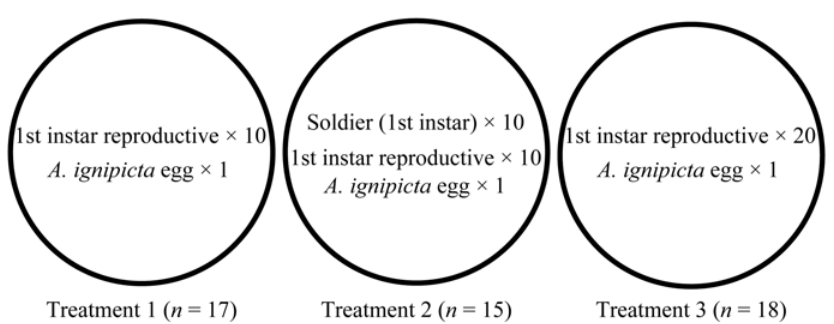
Fig. 2. The design of the egg hatching experiment. Each petri dish was 3.5 cm in diameter. In treatments 1 and 2, the number of non-soldier first instar aphid nymphs was equal. In treatments 2 and 3, the total number of aphids (non-soldier first instar nymphs plus soldiers) was